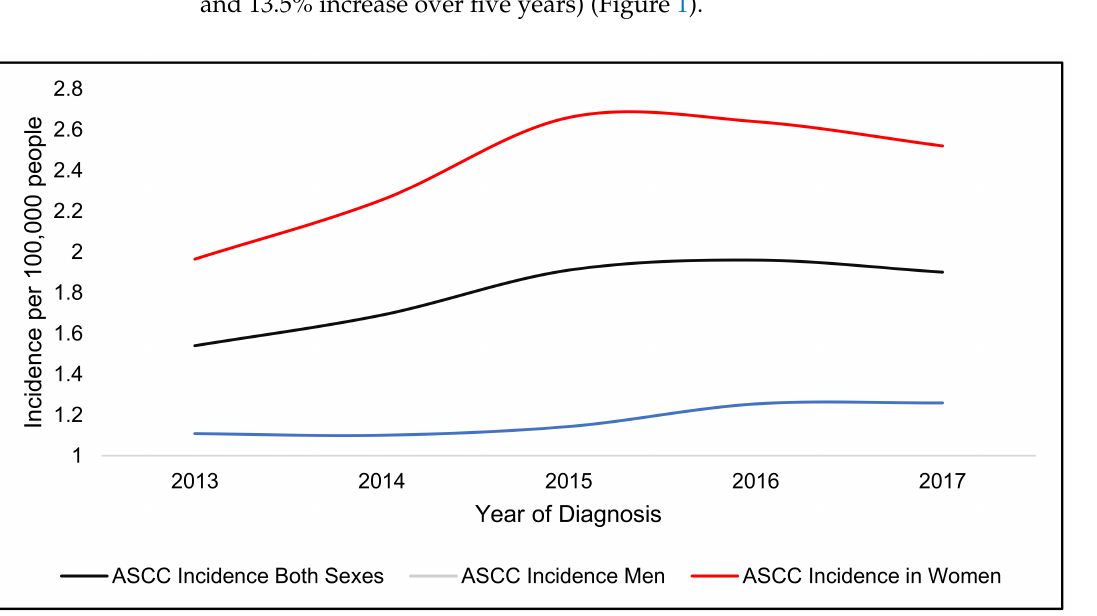
Figure 1. Incidence (per 100,000 people) of Anal SCC in England from 2013–2017 and gender.